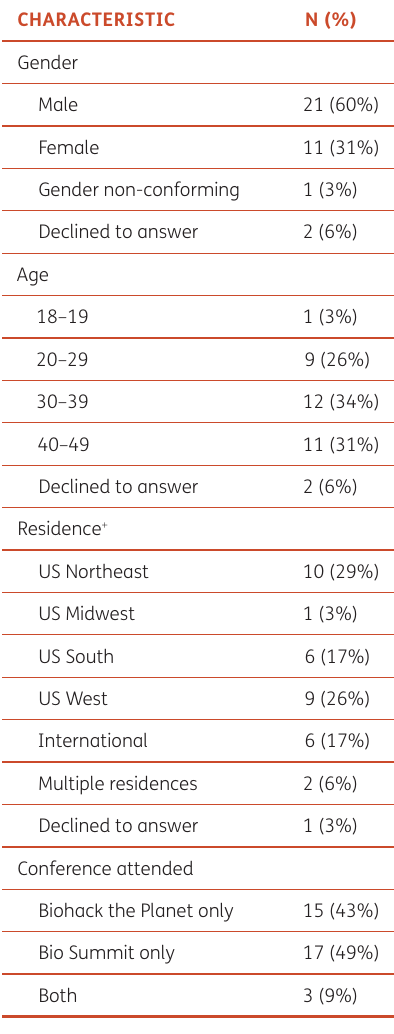
Table 1 Characteristics of interviewees ( N =